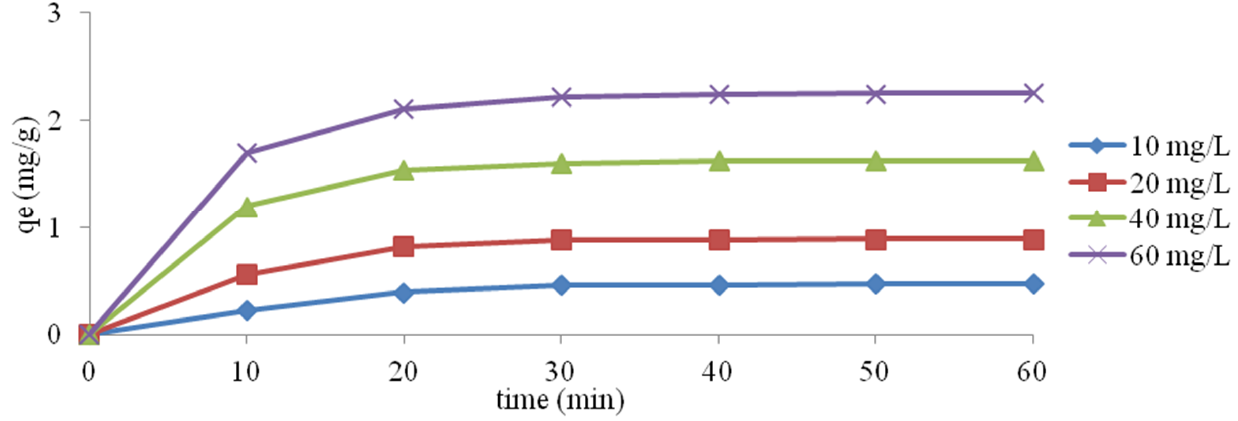
Figure 1. Influence of initial concentration and contact time on the exchange of NH 4+ ions.